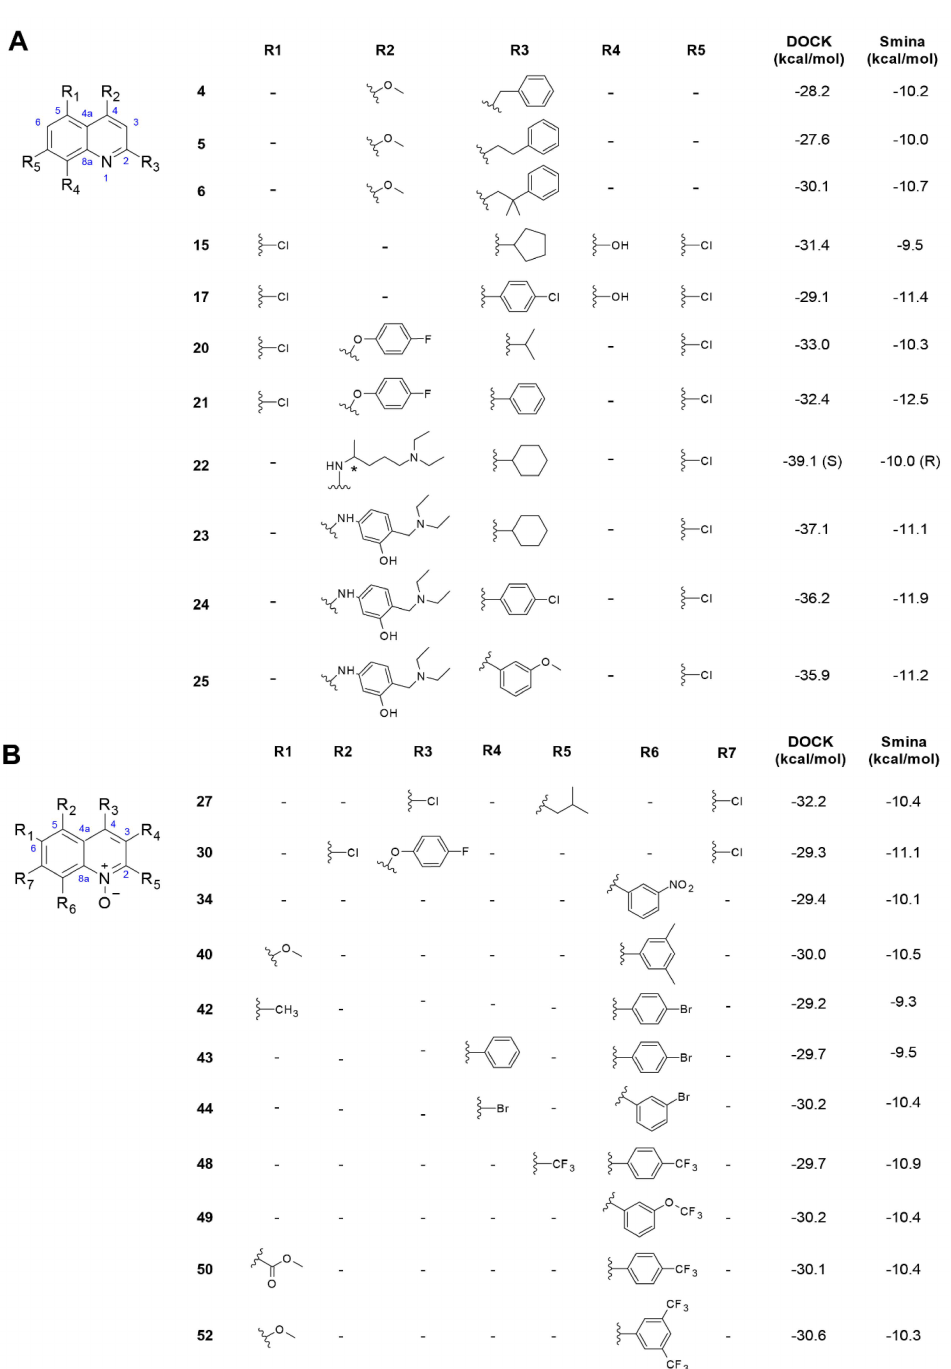
Figure 3. Compounds from libraries L1 ( A ) and L2 ( B ) with the most favorable energy scores. The compounds were selected according to the cut-off values defined in Section 3.1. For compound 22, position of the stereocenter is indicated with “*” and the most favorable, lowest, energy score between the two stereoisomers is shown for each